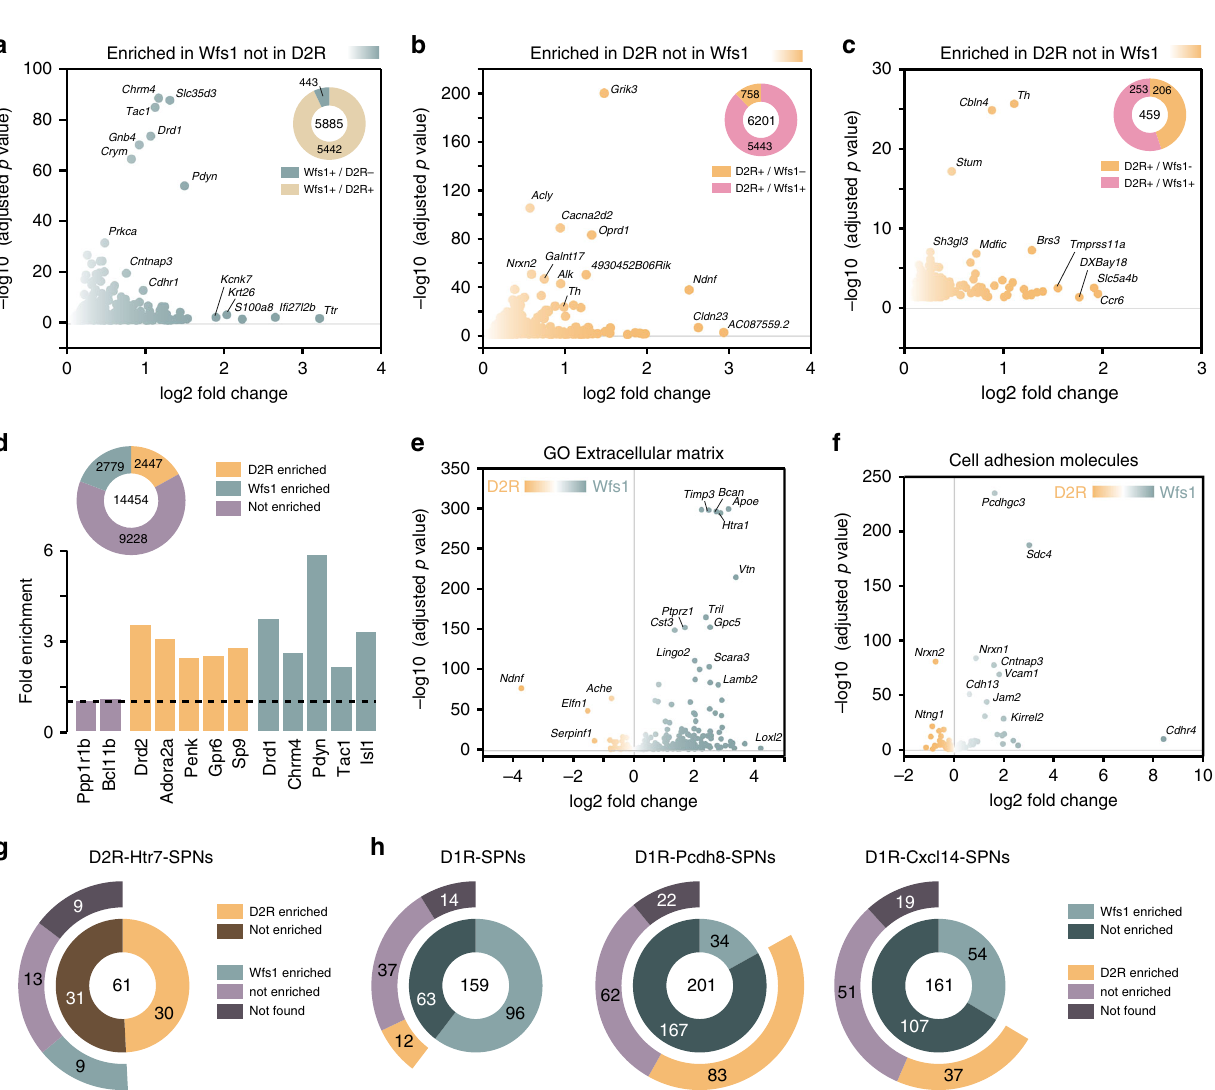
Fig. 5 Molecular characterization of Acb WFS1 neurons. a Volcano plot depicting protein-coding genes selectively enriched in the Acb of WFS1 neurons. Volcano plot depicting protein-coding genes selectively enriched in the Acb of D2R neurons without ( b ) or after fi ltering the pellet fraction with the input fraction ( c ) compared with Acb Wfs1 neurons. d Fold-change of markers enriched from the Acb pellet fraction of Wfs1-RiboTag mice vs D2-RiboTag mice. Volcano plots of GO enrichment analysis of genes related to extracellular matrix ( e ) including cell-adhesion molecules ( f ) in the Acb D2R and WFS1 neurons. ( g ) Doughnut chart showing the overlap and distribution of Acb D2R- and WFS1-enriched genes found in our study among the genes de fi ning the D2R-Htr7 SPNs 13 . h Doughnut chart showing the overlap and distribution of Acb D2R- and WFS1-enriched genes found in our study among the genes de fi ning the D1R-SPNs and some of their discrete subpopulations (D1R-Pcdh8-SPNs and D1R-Cxcl14-SPNs) 13